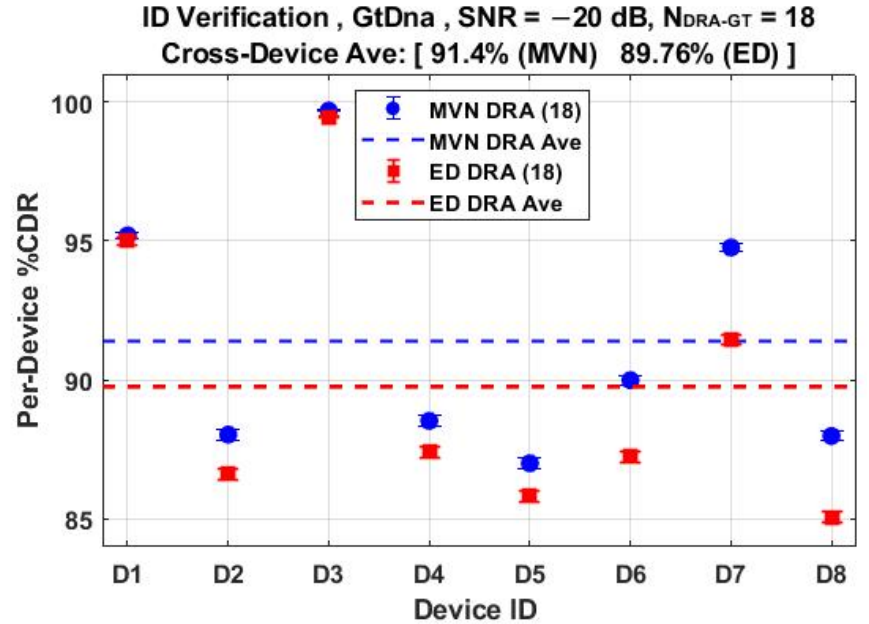
Figure 17. Per-device ID verification performance for jointly selected N DRA-GT = 18 features using the N Mdl = 56 MDA models used for generating %C results in Figure 13. Results generated under SNR = − 20 dB conditions using ED ( ■ ) and MVN ( ● ) measures of similarity.